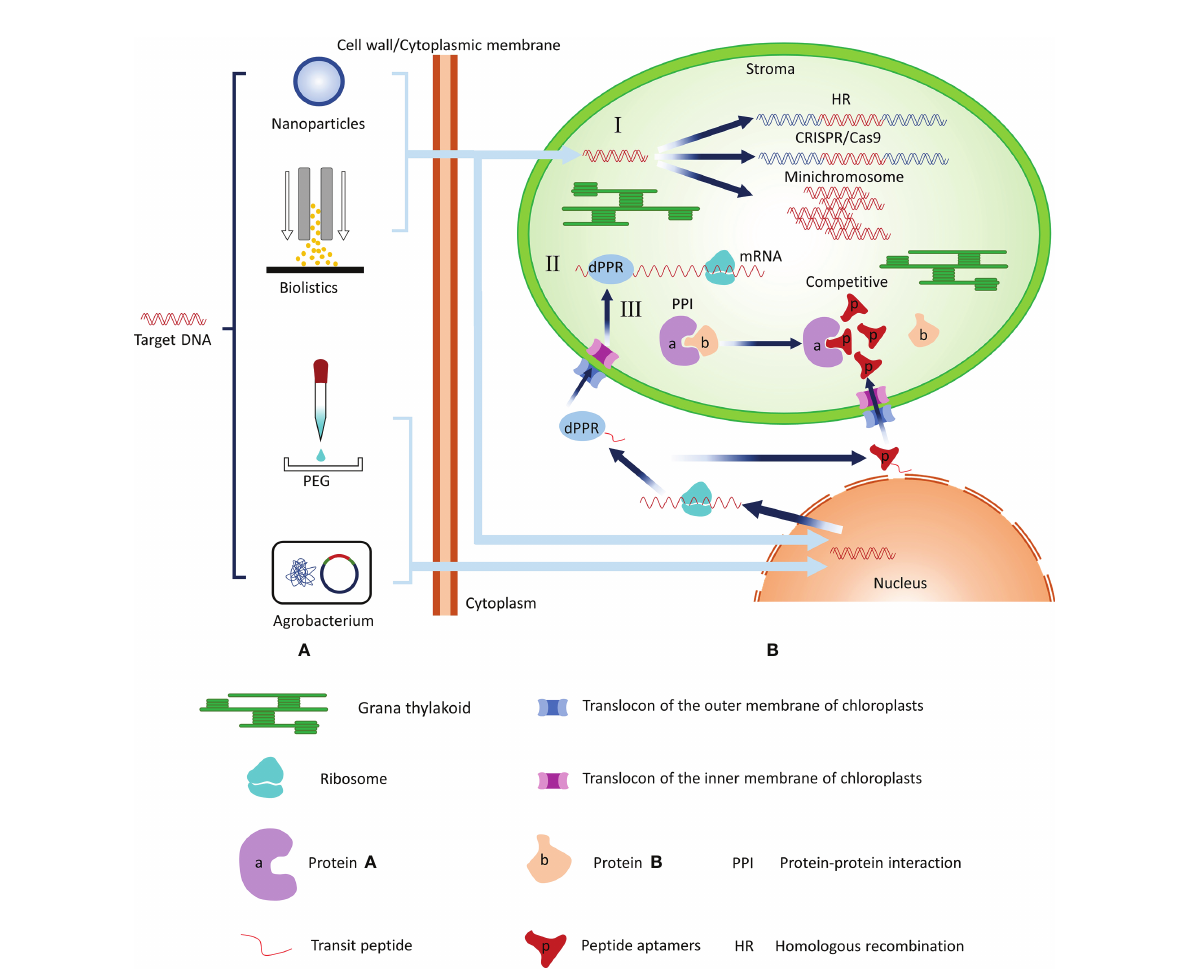
FIGURE 1 Summary of the chloroplast transformation technologies and potential regulation methods for chloroplast gene expression. (A) Technologies that introduce target genes into chloroplasts include biolistics and nanoparticle-mediated transformation. Biolistics and nanoparticle-mediated methods require that foreign plasmid DNA be adhered to the surface of metal particles or wrapped in nanoparticles and then DNA be mediated by power of free-power into chloroplasts or nucleus. PEG can change the structure of cell membranes such that foreign plasmid DNA can enter plant cells and nucleus. The Agrobacterium infection method transforms the recombinant plasmid into competent cells of Agrobacterium and then infect plant cells with Agrobacterium to achieve nuclear transformation. (B) I: Regulation of chloroplast gene expression at the DNA level. Target genes can directly enter the chloroplast and regulate gene expression at the DNA level through CRISPR/Cas9 techniques via the HR method or foreign DNA functions as an independent minichromosome. II: Regulation of chloroplast gene expression at the RNA level. After the dPPR gene enters the recipient cell, it replicates and expresses dPPR protein. The fused transit peptide of the dPPR protein guides it to enter the chloroplast through the TOC/TIC transport complex. TOC, translocase at the outer envelope membrane of the chloroplast; TIC, translocase at the inter-chloroplast membrane. The dPPR protein directly binds with mRNA to regulate the expression of chloroplast genes. III: Regulation of chloroplast gene expression. After the target gene enters the recipient cell, it replicates and expresses in the nucleus to construct the aptamer. The aptamer with fused transit peptide can be guided into the chloroplast and interacts with the corresponding chloroplast protein to affect the chloroplast protein